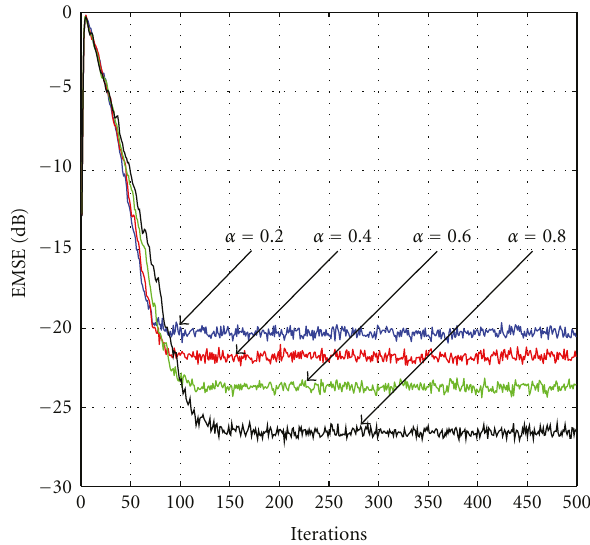
Figure 2: E ff ect of α on the learning curves of the proposed algorithm in an AWGN noise environment scenario for p = 1.